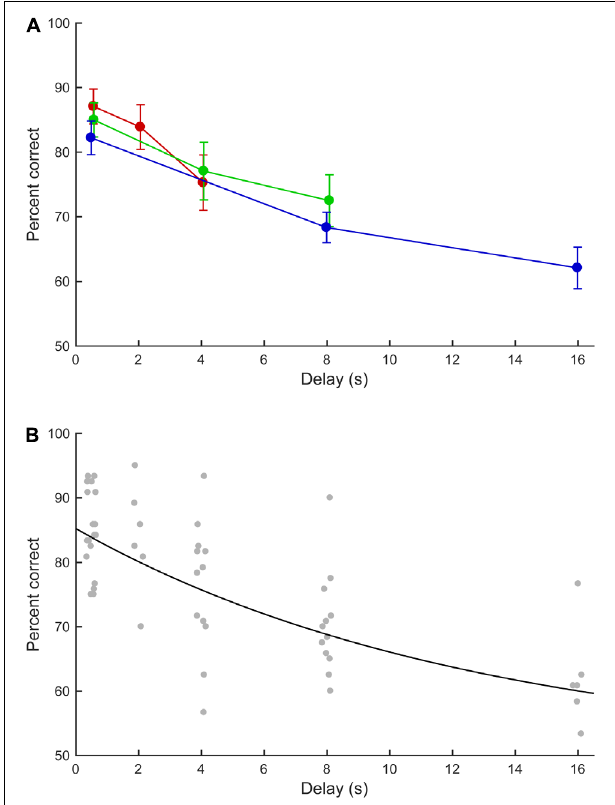
FIGURE 6 | Delayed matching-to-sample task performance as a function of delay length. (A) Mean performance of the marmosets in the short (red line), middle (green), and long (blue) delay conditions. The error bars represent standard errors. (B) Estimated performance curve based on the parameters described by Lind et al. (2015). The data for individual marmosets are indicated by gray